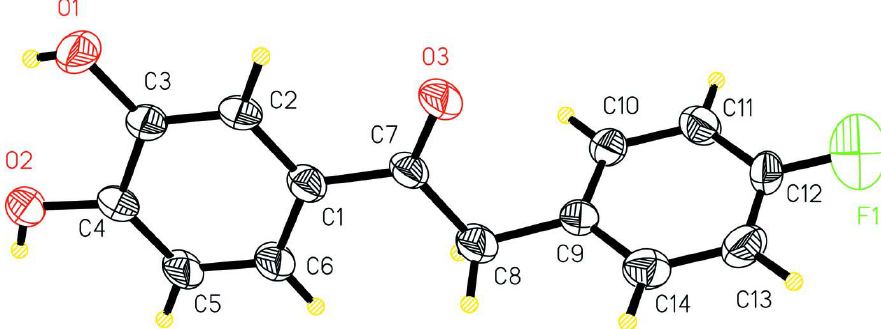
The molecular structure of (I) showing 30% probability displacement ellipsoids for the non-hydrogen